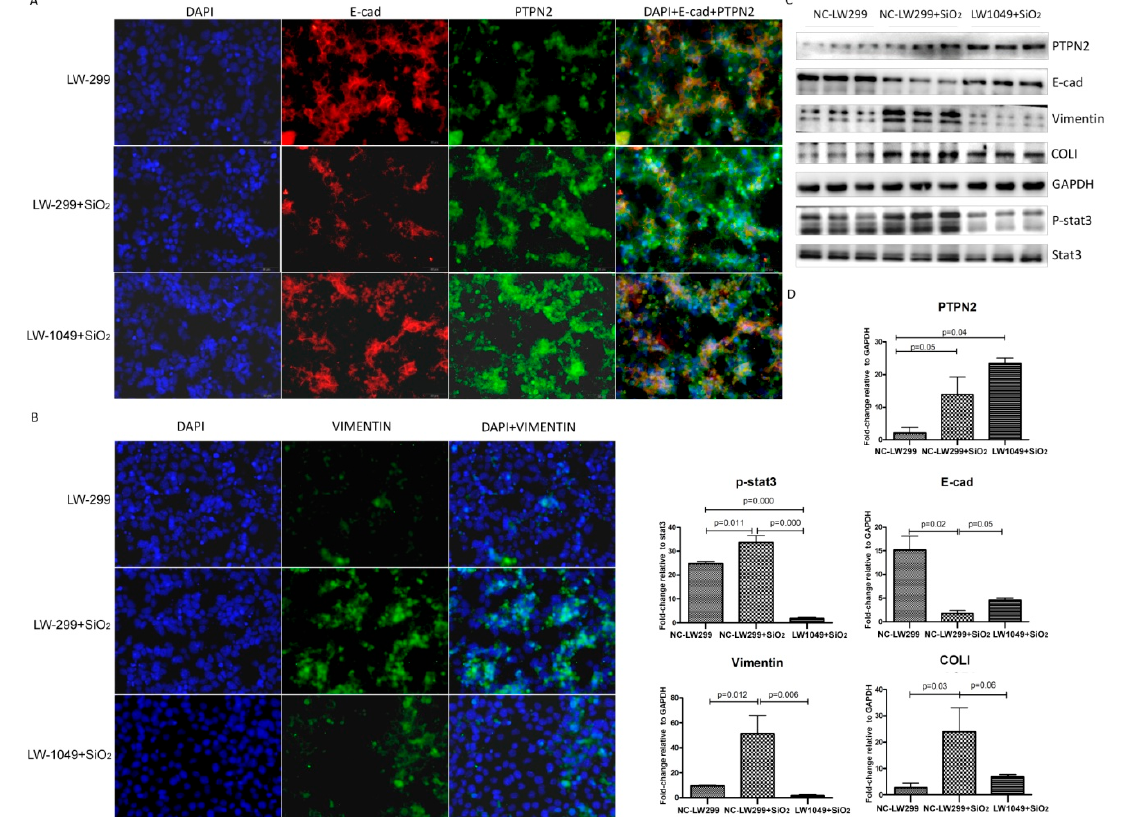
Figure 6. Effect of PTPN2 overexpression on SiO2 stimulated MLE-12 cells. ( A ) Immunofluorescent staining for PTPN2 and E-cad expression in NC-LW299 and LW1049 cells with SiO 2 ; Scale bars: 50 μ m. ( B ) Immunofluorescent staining for Vimentin expression in NC-LW299 and LW1049 cells with SiO 2 ; Scale bars: 50 μ m. ( C ) Western blot for the expression levels of PTPN2, E-cad, Vimentin, and p-STAT3 in NC-LW299 and LW1049 cells with SiO 2 . ( D ) The corresponding densitometry data for the expression levels of PTPN2, E-cad, Vimentin, and p-STAT3 in NC-LW299 and LW1049 cells with SiO 2 . Relative densities of PTPN2, E-cad, and Vimentin were normalized to GAPDH, and the relative density of p-STAT3 was normalized to STAT3. The relative expressions were expressed as the fold-change of specific bands in the negative control group. Bar graphs are the mean ± SD of two separate experiments, each performed in triplicate. Statistical analysis was performed using a t-test with SPSS20.